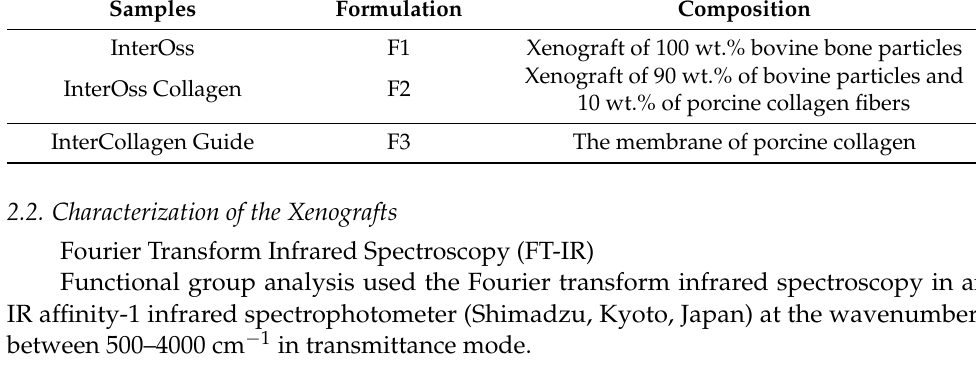
Table 1. The formulation composition of the xenografts used in this research.